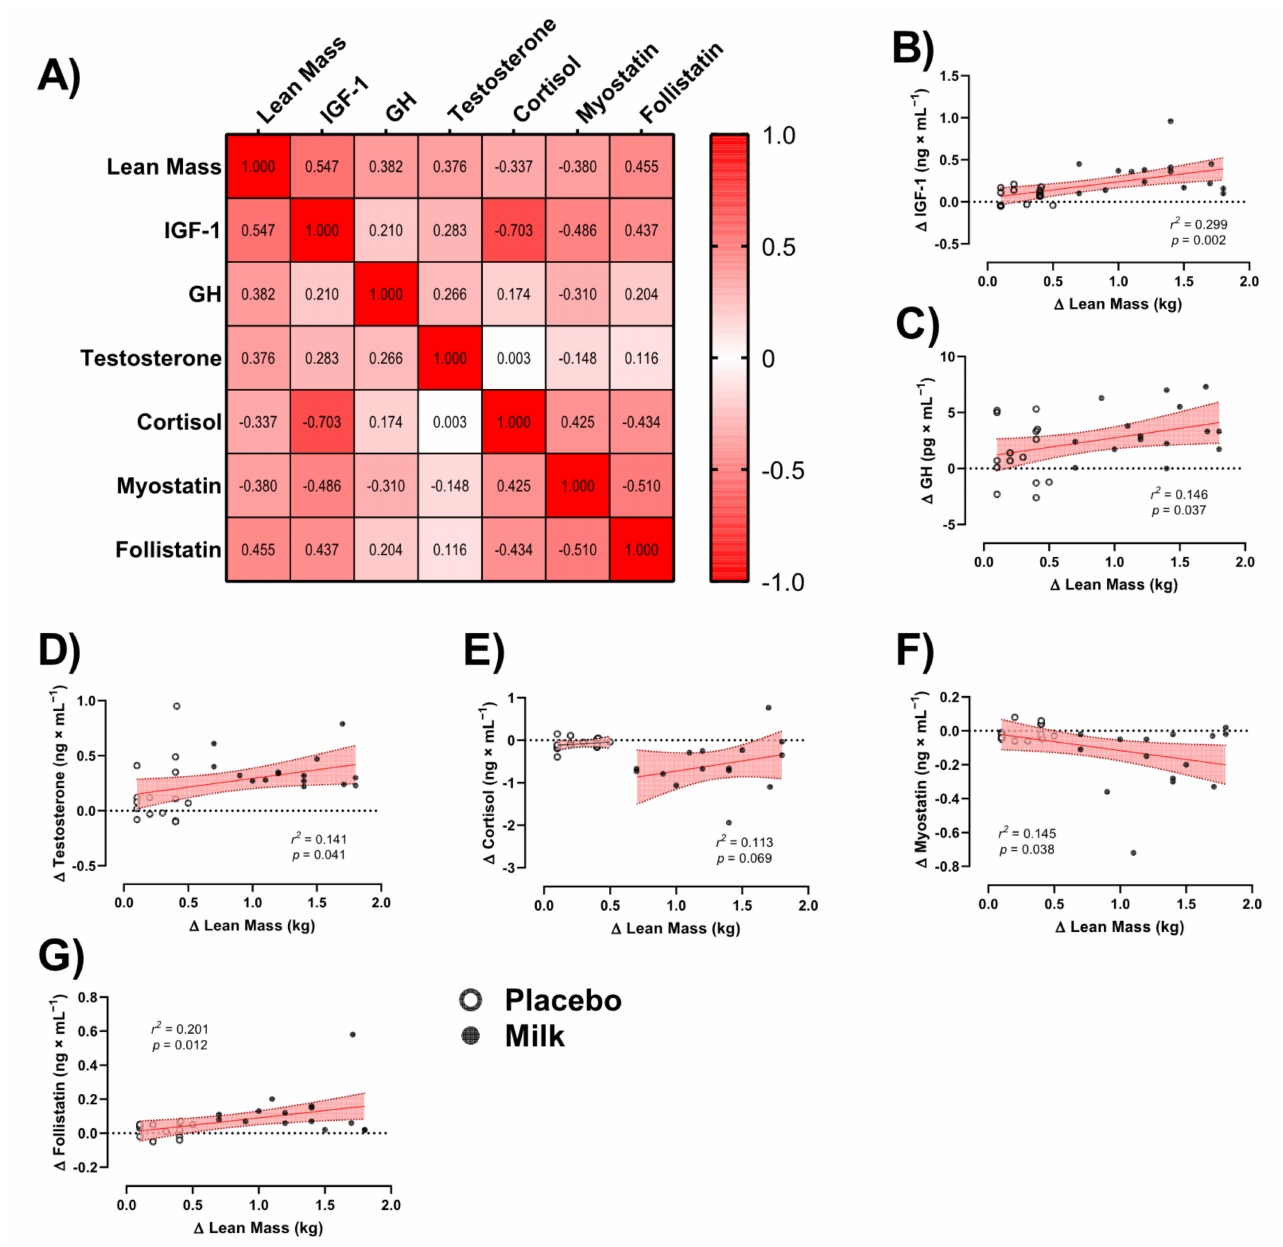
Figure 4. Relationships between change in lean mass ( ∆ lean mass (kg)) and change in endocrine markers ( ∆ (hormone)). ( A ) Correlation matrix of ∆ lean mass and endocrine markers, r values as shown. Key indicates magnitude of r (red = − 1 or 1, white = 0). ( B – G ) linear regression (Pearson’s) of ∆ (hormone) as a function of ∆ lean mass (kg). Linear regression indicated by solid red line, 95% confidence intervals indicated by shaded red zones. Open white circles indicate placebo group; closed black circles indicate high-protein diary milk ingestion